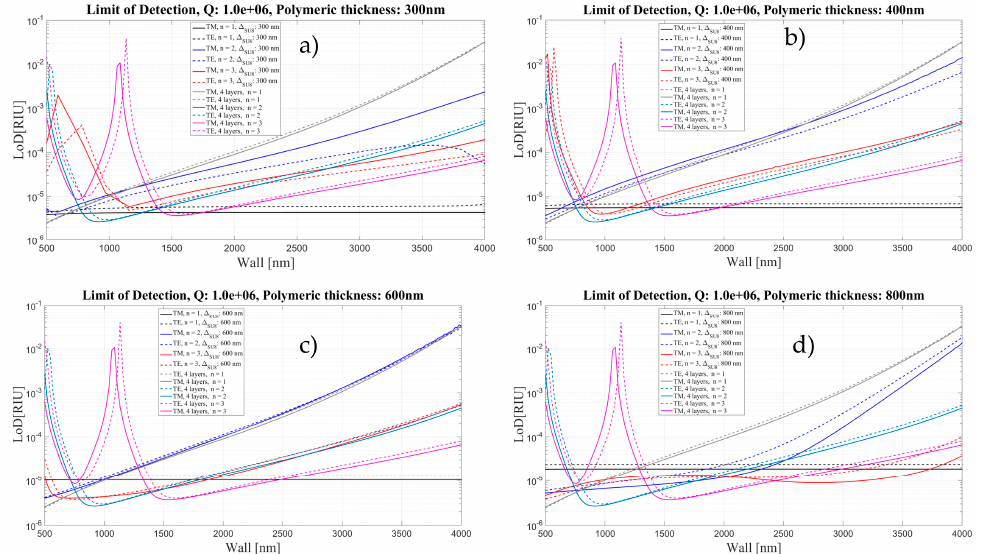
Figure 20. Limit of Detection for the four- and five-layer models as a function of Wall thickness for two different polarizations and three mode orders, corresponding to different thickness of polymeric layer: ( a ) 300 nm; ( b ) 400 nm; ( c ) 600 nm; and ( d ) 800 nm. Q is assumed to be about 10 6 .